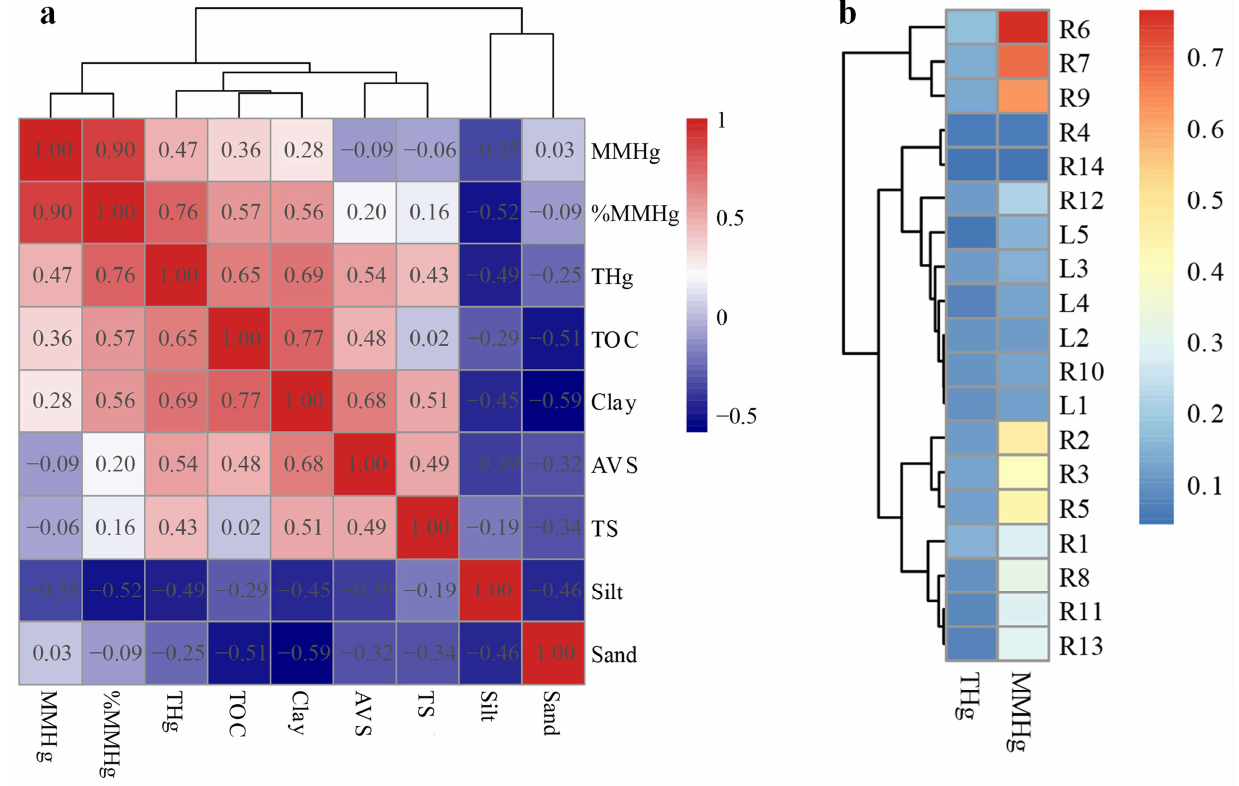
Figure 7. Cluster analysis of different pollutants ( a ) and sampling sites ( b ).